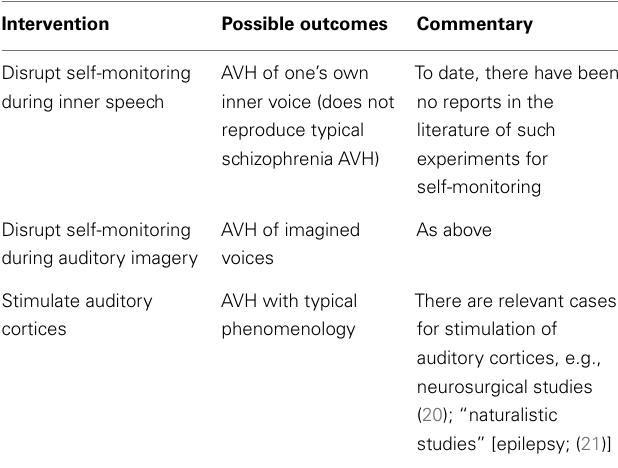
Table 1 |Auditory verbal hallucination mechanisms: proof of concept studies